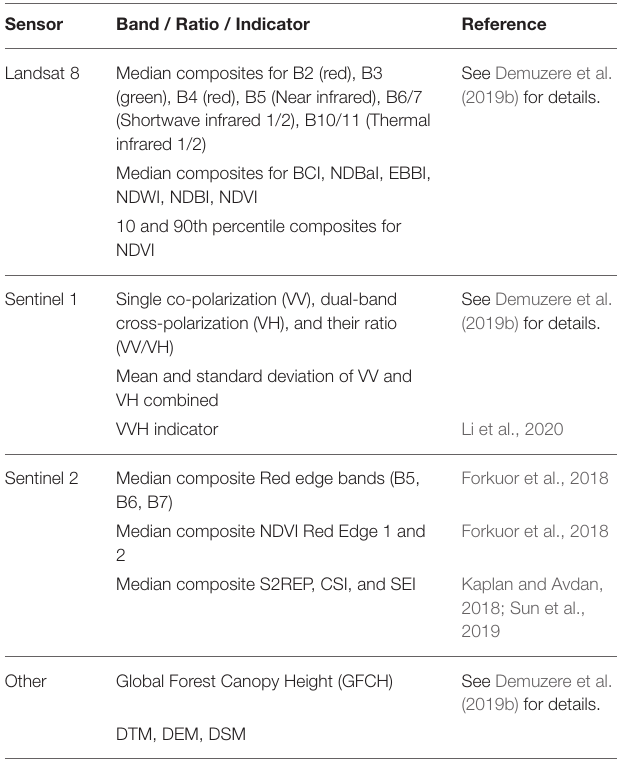
TABLE 2 | Earth observation input features currently available for the LCZ